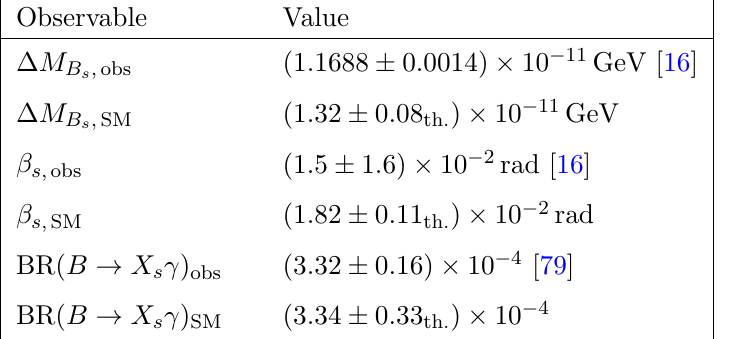
Table 5 . Experimental and SM predictions for B s -meson mixing observables (mass splitting and the CP violating angle) and radiative B-meson decays. The subscript th. in some errors refers to theoretical.